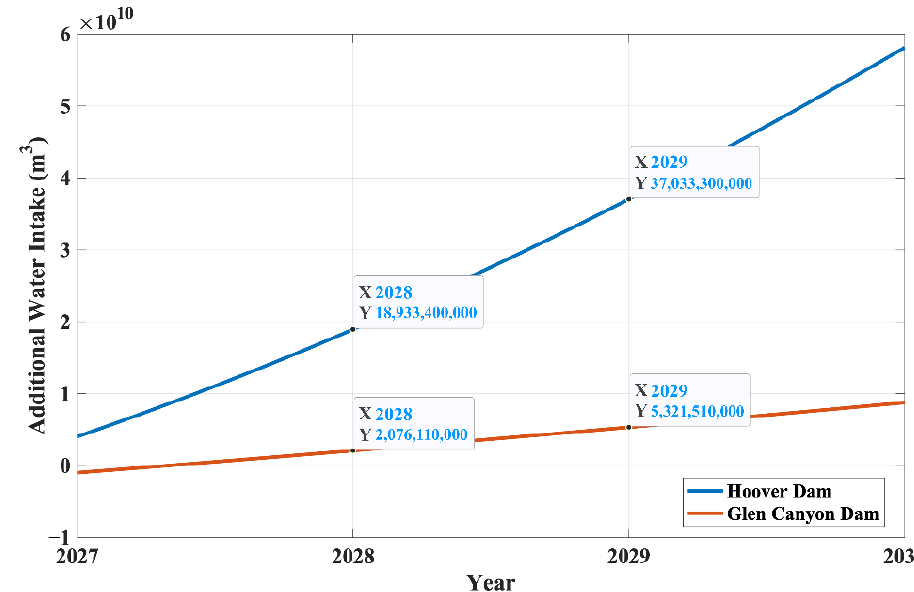
Figure 13. Volume of water to be introduced at the HD and the GCD.